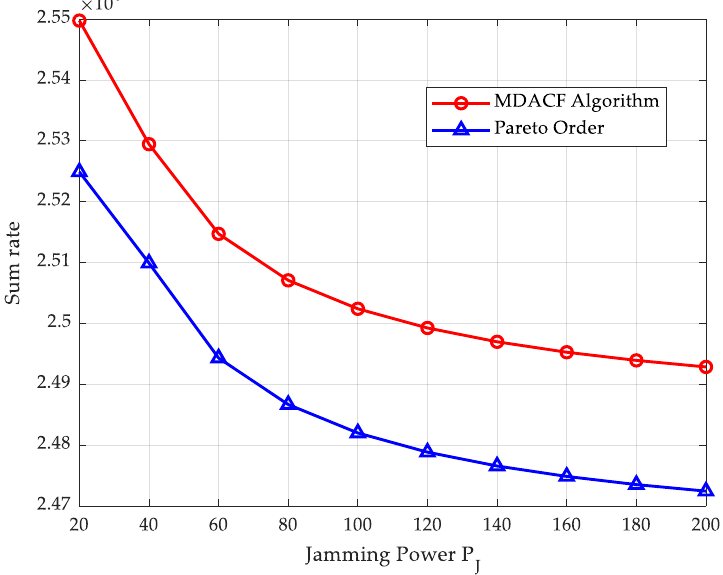
Figure 5. Schematic representation of the effect of interference power on the proposed algorithm.